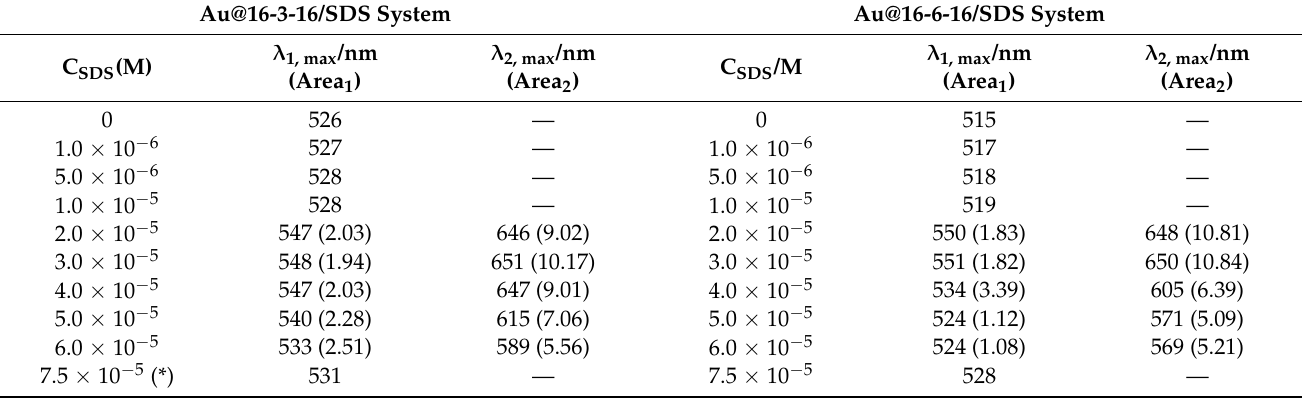
Table 1. Deconvolution parameters for the experimental spectra obtained by Au@16-3-16/SDS